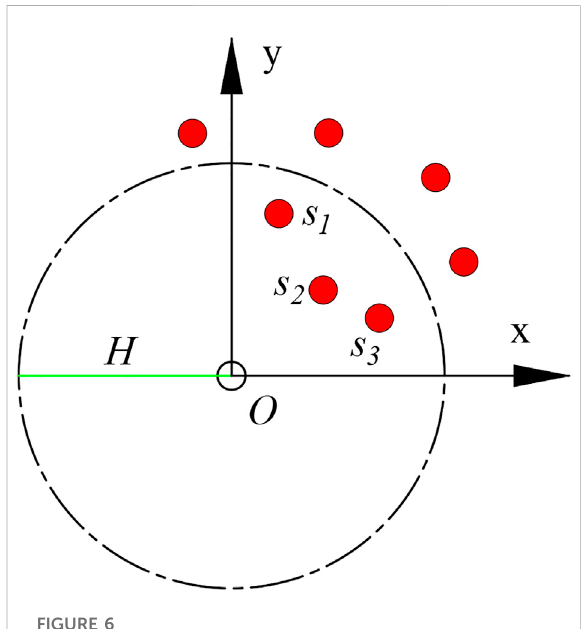
FIGURE 6 Predictionmethodof S.alterni fl ora diffusion,inwhichthered dots indicate the existing distribution of S. alterni fl ora , O indicates the point to be predicted, H indicates the diffusion distance, and the red dots marked with S indicate the S. alterni fl ora within the radius H